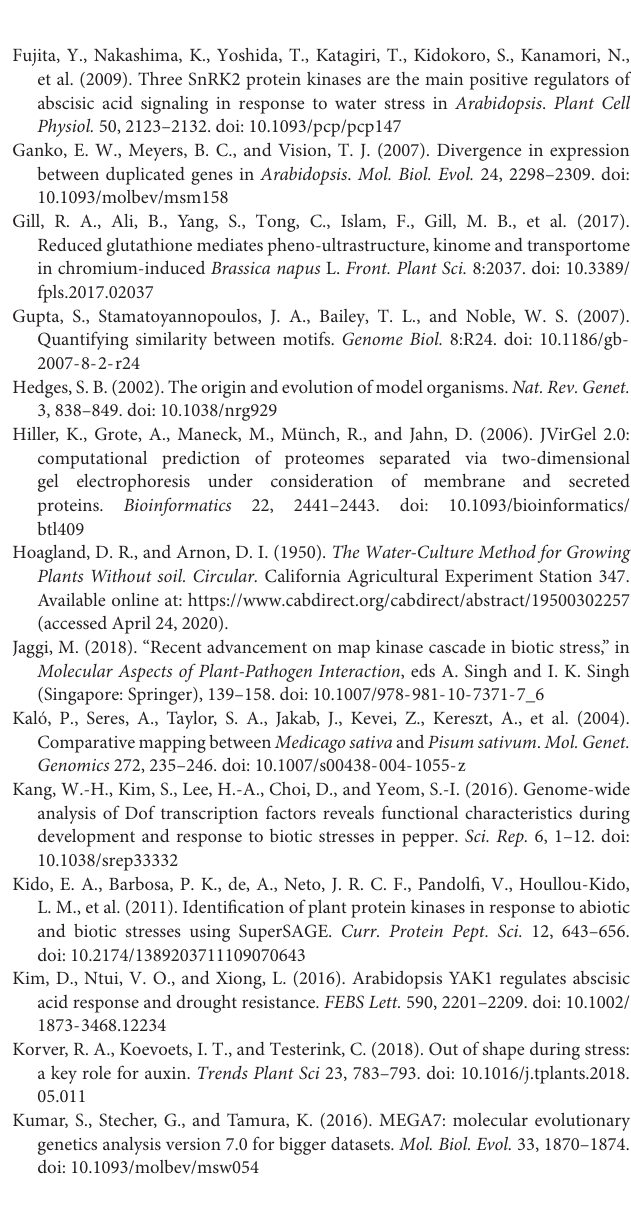
performed in the present work. NEC, not expressed in this contrast; const., constitutive expression; UR, up-regulated expression; DR, down-regulated expression; log2FC, log of the expression ratio obtained from respective treatment vs. control contrast. Supplementary Table 13 | Complete NeVOmics tabular output for biological process enrichment analysis of T150 bona fide VuPKs up-regulated. Supplementary Appendix 1 | Melting curves for target transcripts used in the present study. Supplementary Appendix 2 | Metrics for cowpea RNA-Seq libraries and transcriptome assembly. Supplementary Appendix 3 | REST software outputs to target transcripts’ relative expression